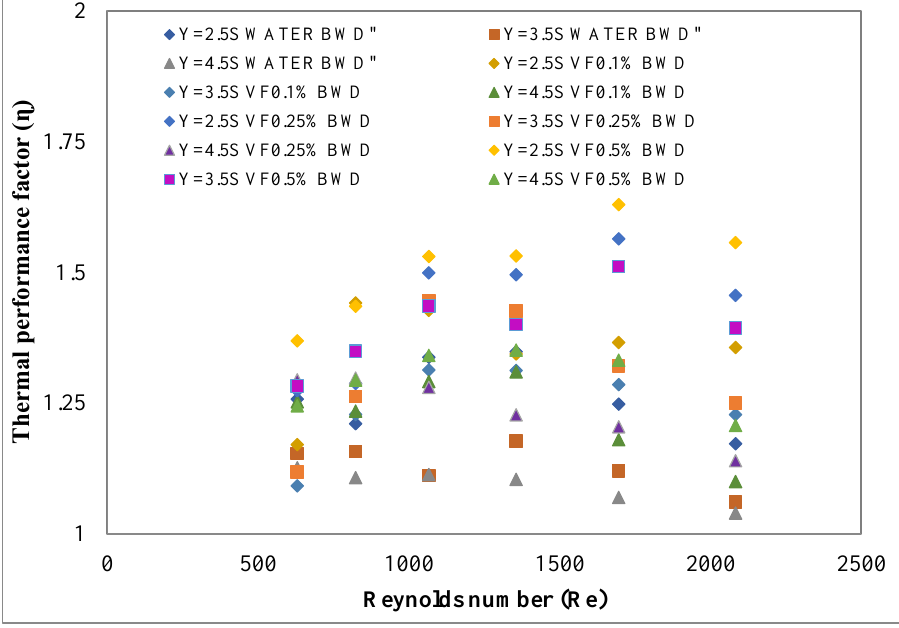
Figure 15. Thermal performance factor versus the Reynolds number for a staggered conical strip insert with the backward arrangement using deionized water and ZrO 2 / deionized water nanofluids under laminar flow conditioned.